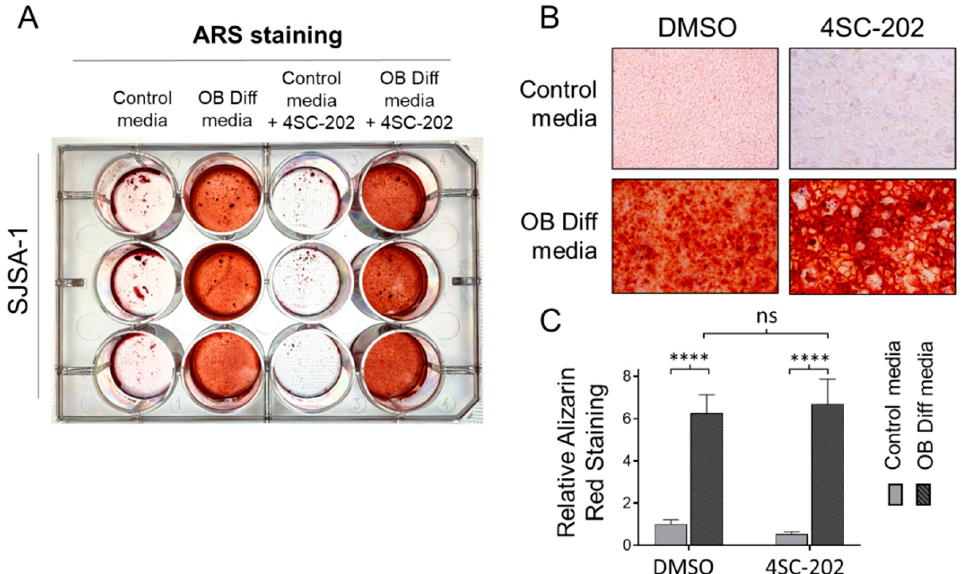
Figure 6. Effect of 4SC-202 on osteoblast-like differentiation and mineralization. ( A ) Representative photo of 12-well plate wells stained with Alizarin Red S after treatment for two weeks with control media or osteoblast differentiation (OB Diff) media or control media + 4SC-202 or OB Diff media + 4SC-202. ( B ) Representative images of the plate wells in A under 10× objective magnification. ( C ) Quantitative results of Alizarin Red S staining in all 4 groups in A. **** p < 0.0001 (two-way ANOVA with Tukey method). Data are presented as mean (SD).